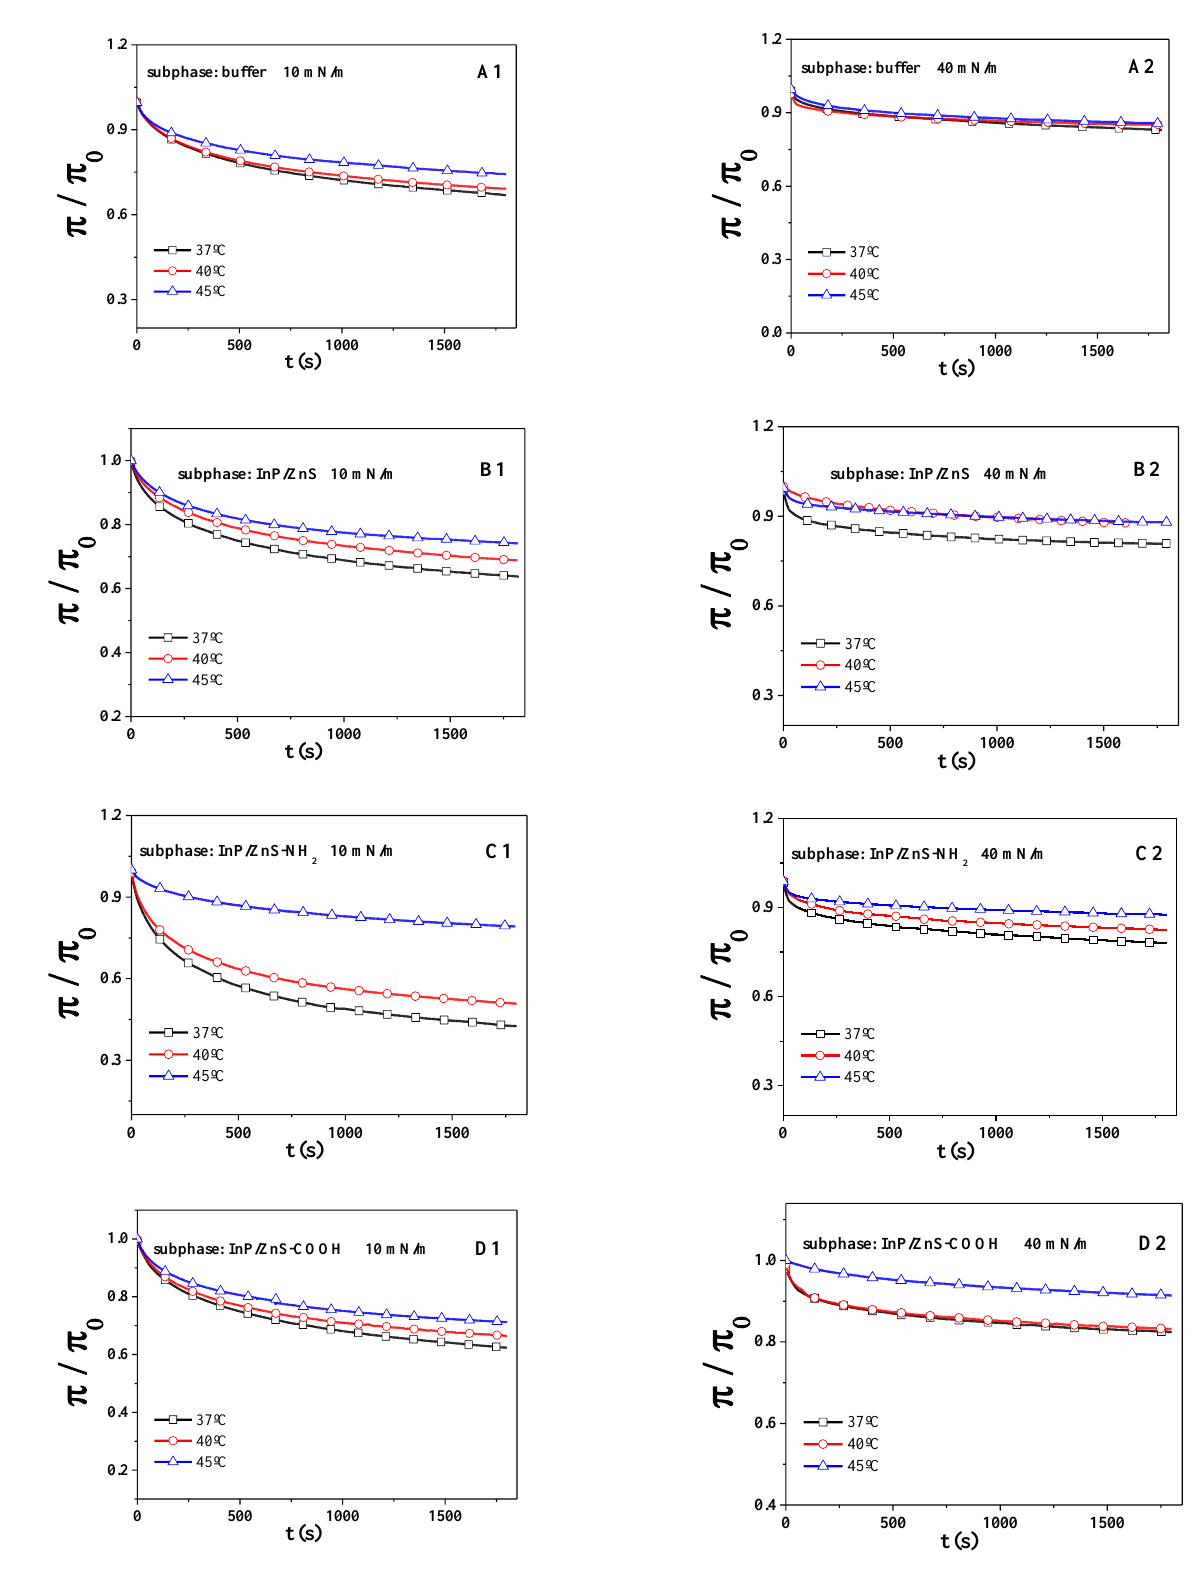
Figure 3. The π / π 0 − t curves of the DPPC/DPPG mixed monolayer in the absence of QDs ( A1 , A2 ) and in the presence of InP/ZnS ( B1 , B2 ), InP/ZnS-NH 2 ( C1 , C2 ) and InP/ZnS-COOH QDs ( D1 , D2 ) at 37 °C, 40 °C and 45 °C.